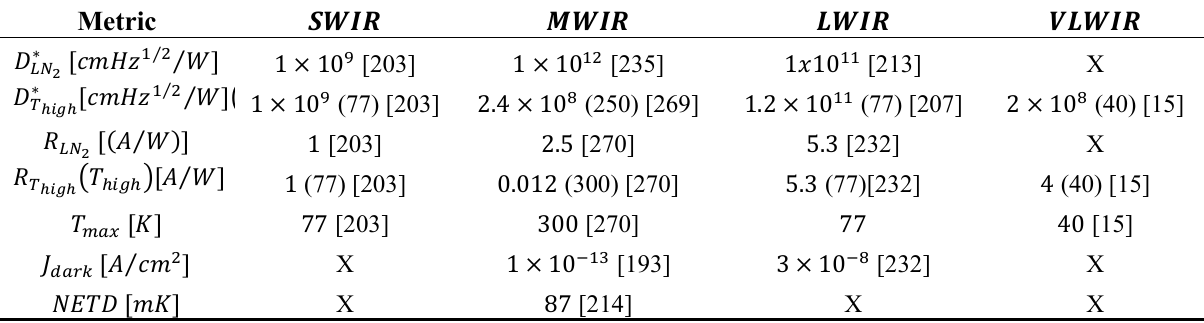
Table 4. Highest reported performance metrics for QDIPs across different wavelength regimes.